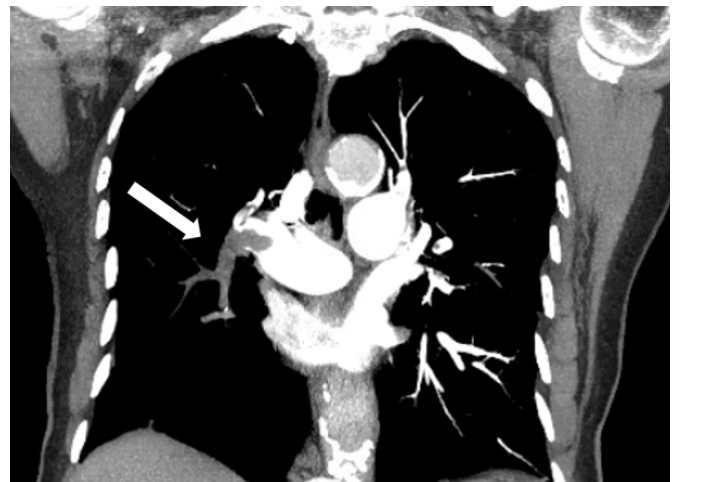
Image 2. Coronal view of the computed tomography pulmonary angiogram. Image is notable for pulmonary embolus within right pulmonary artery trunk with almost complete occlusion of segmental branches (arrow).